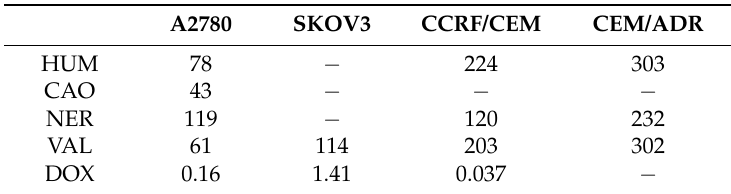
Table 1. IC 50 values (µM) for sesquiterpenes and DOX after 72-h incubation—indicates the value was impossible to calculate. Calculated by CalcuSyn (version 1.1) software.